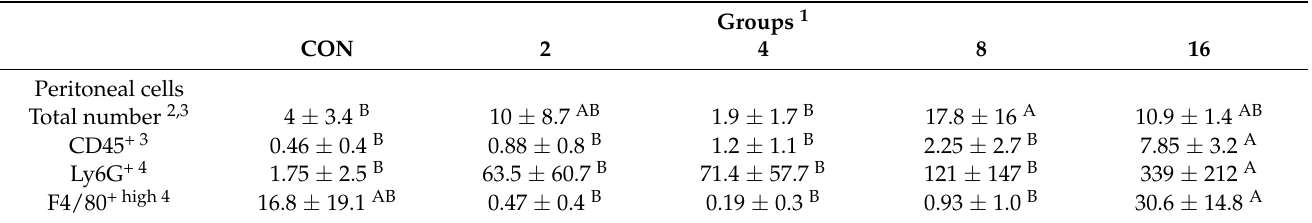
Table 1. Total number and populations of cells obtained by lavage of the peritoneal cavity measured in control mice that received PBS and in mice injected with zymosan. Groups 1 CON